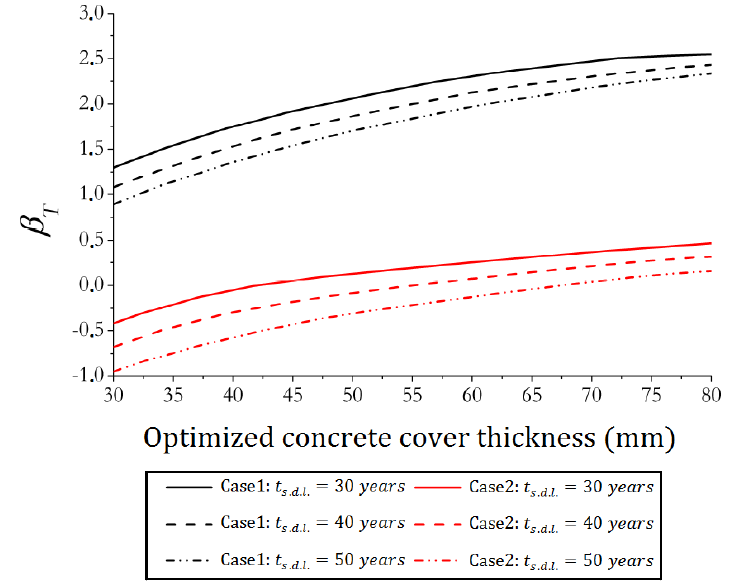
Figure 5. Optimised concrete cover thickness.